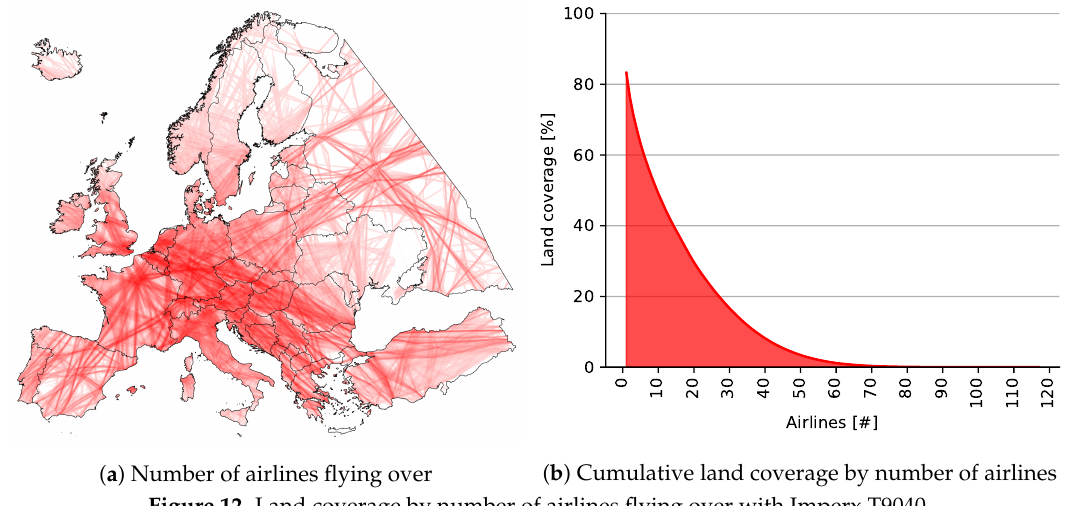
Figure 12. Land coverage by number of airlines flying over with Imperx